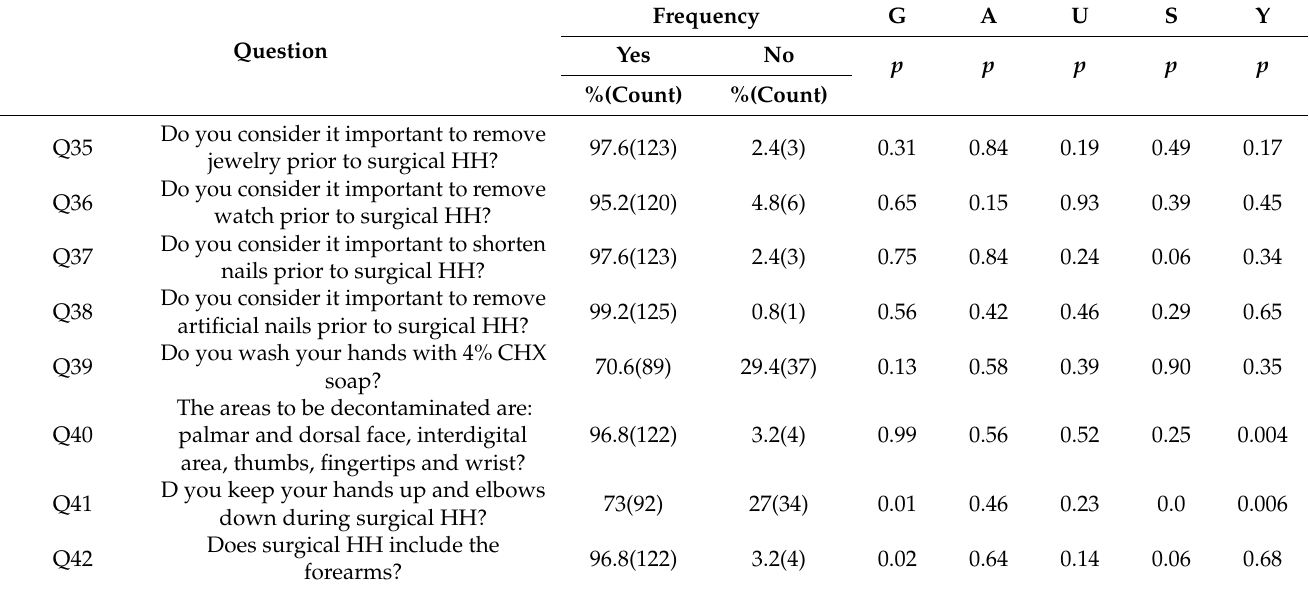
Table 4. Response rate percentage regarding infection control by surgical decontamination. Results of statistical significance tests.